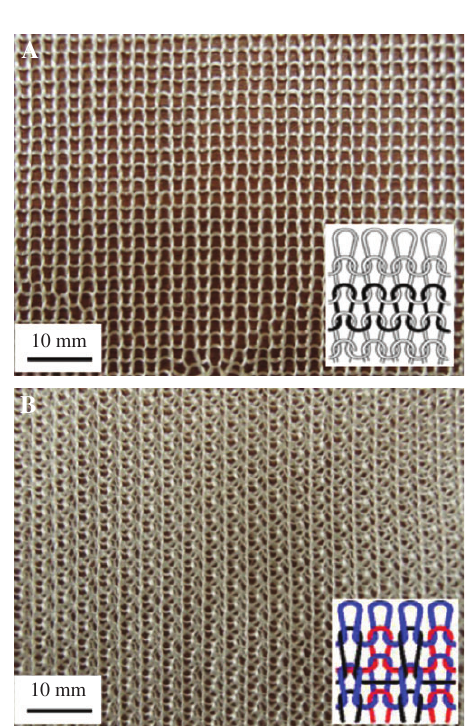
Figure 1 Photograph and schematic diagram of weft knitted fabrics. (A) Plain knit, (B)